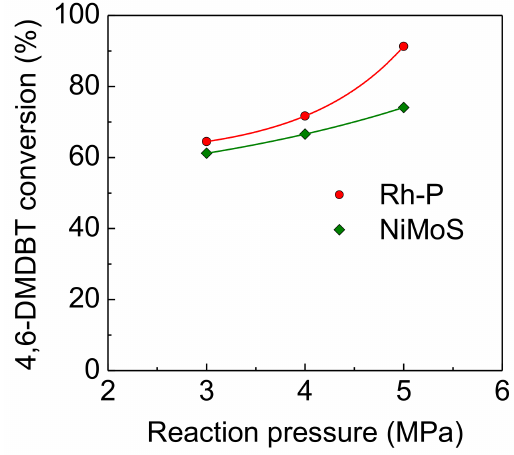
Figure 7. Effect of reaction pressure on the activities of Rh-P and NiMoS catalysts for the HDS of 4,6-DMDBT at 310 ◦